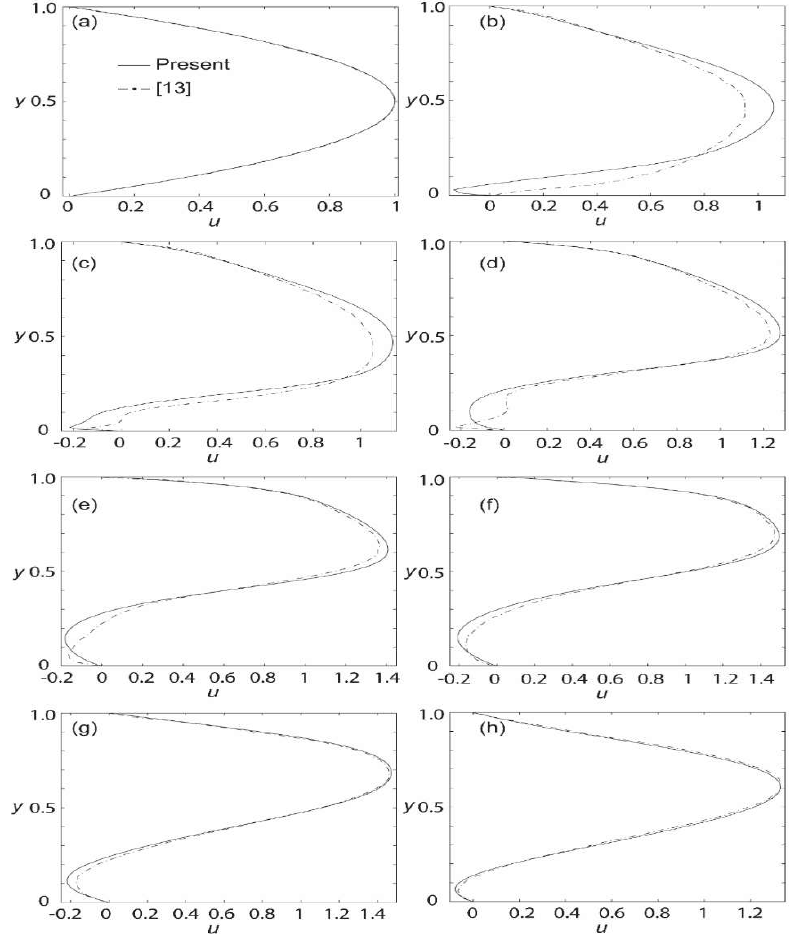
Figure 3. Verification of axial velocity profiles at various parts of the channel for 𝐵 (cid:3042) (cid:3364)(cid:3364)(cid:3364) = 8T and Re = 250 against [13]: x = ( a ) 0; ( b ) 2.5; ( c ) 2.6; ( d ) 2.8; ( e ) 3.1; ( f ) 3.5; ( g ) 4.5; and ( h )